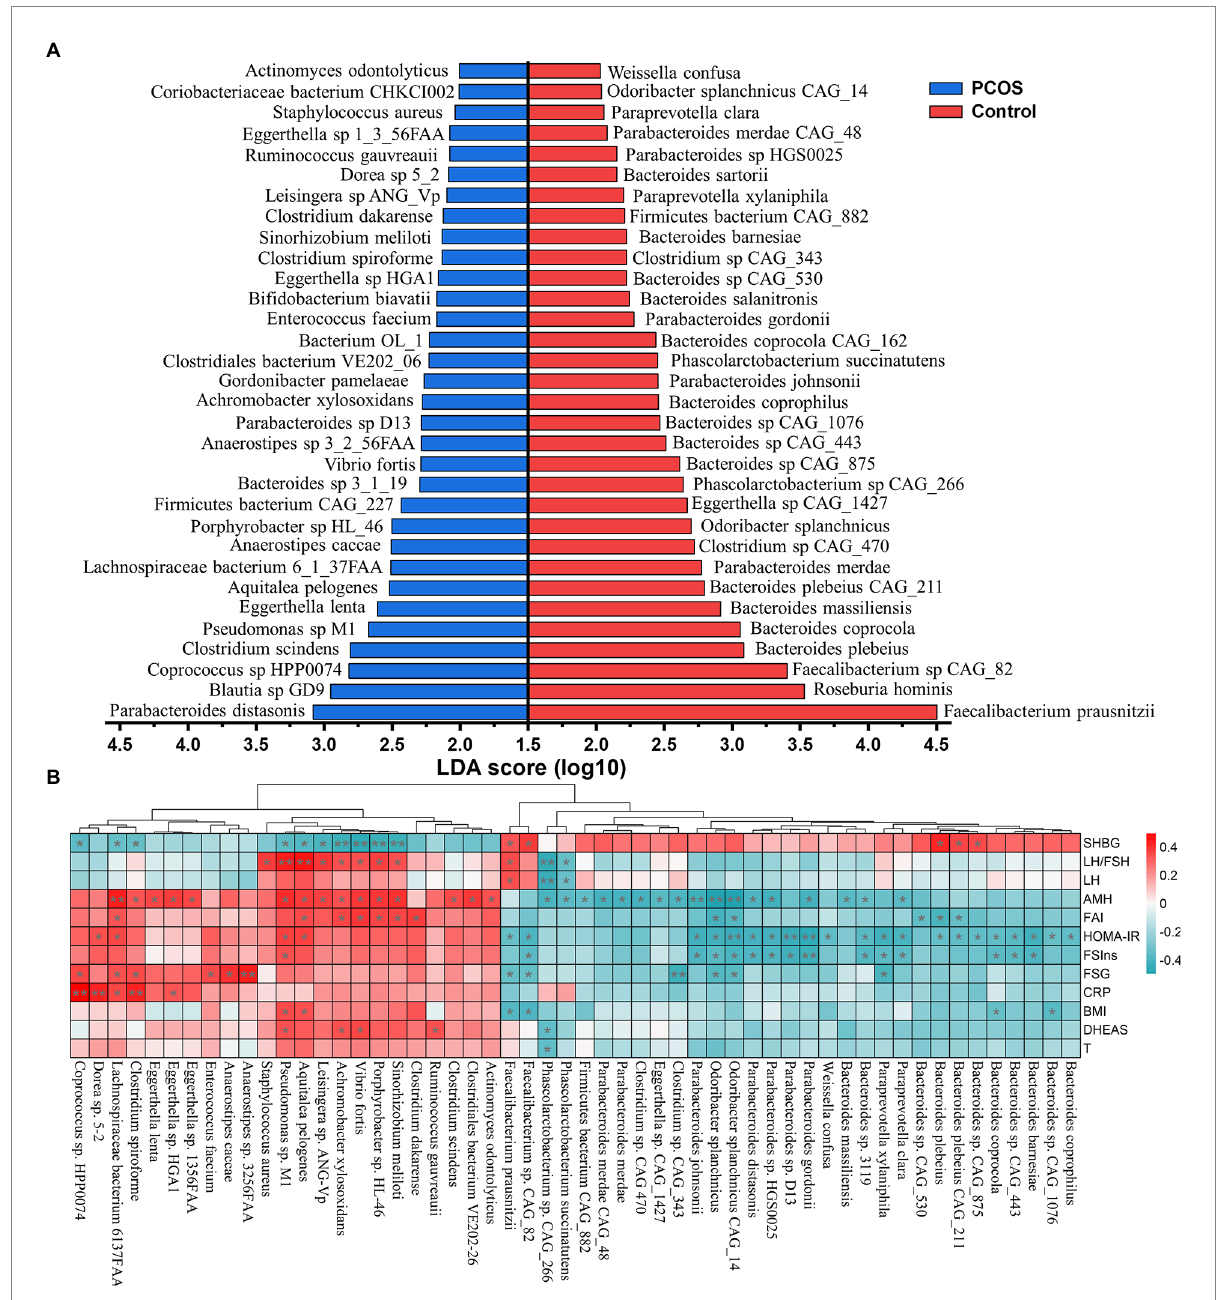
FIGURE 1 Identifying the significant changed gut microbial strains in PCOS. (A) Linear discrimination analysis (LDA) effect size (LEfSe) approach was used to identify the discriminatory microbial species with the LDA score (log10) ≥ 2.0 and the adjusted p < 0.05. (B) Correlation heatmap analysis between the differential strains and clinical variables in PCOS. SHBG, sex hormone binding globulin; LH, luteinizing hormone; LH/FSH, the ratio of LH to follicle-stimulating hormone (FSH); AMH, Anti-Mullerian hormone; FAI, free androgen index; FSIns, fasting serum insulin; HOMA-IR, homeostasis model assessment of insulin resistance; FSG, fasting serum glucose; CRP, C-reactive protein; BMI, body mass index; T, total testosterone; and DHEAS, dehydroepiandrosterone sulfate. Correlation coefficient between two indicators was calculated based on Pearson’s principle. Red and green colors represented positive and negative correlation, respectively, and the color depth showed the correlation coefficient size. * p < 0.05, ** p <